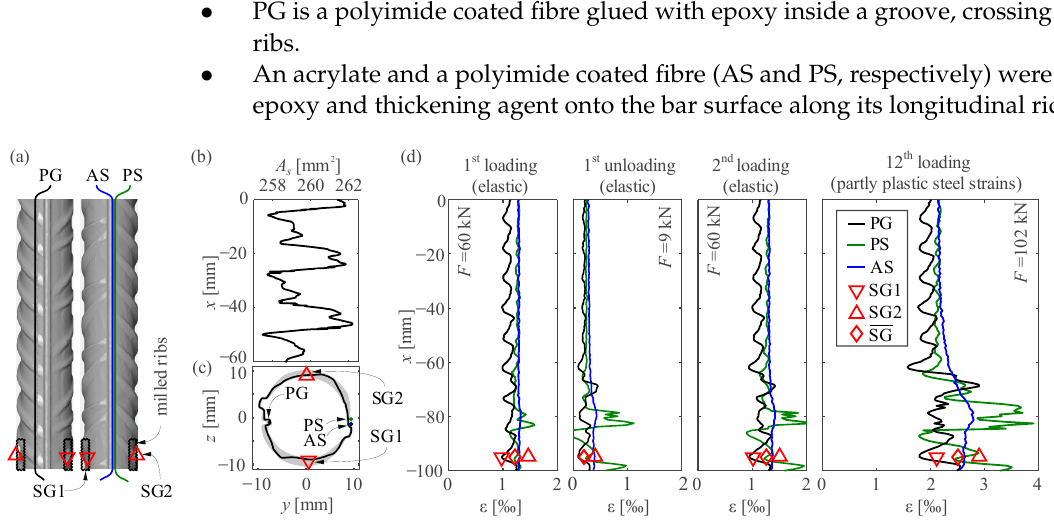
Figure 10. Influence of reinforcing bar geometry and local milling for installation of strain gauges on strain measurements studied on specimen cw03 tested under direct tension: ( a ) Surface scan with instrumentation (SG: strain gauges; PG: polyimide FOS in groove; PS: polyimide FOS on surface; AS: acrylate FOS on surface); ( b ) cross-sectional area distribution; ( c ) bar cross-section and projected total rib area (grey) with instrumentation and ( d ) strain measurements for selected steps (DFOS shows raw data with removed outliers).